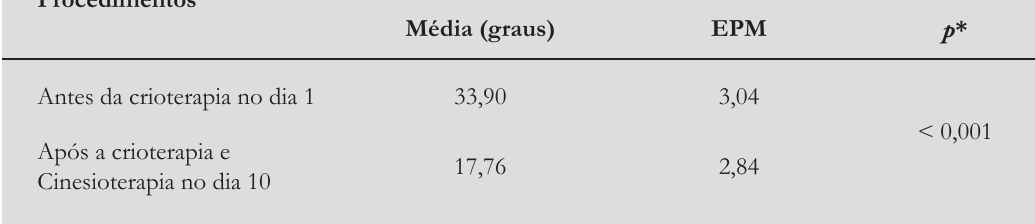
Tabela 1 - Valores das médias goniométricas das articulações do punho, metacarpofalangeas